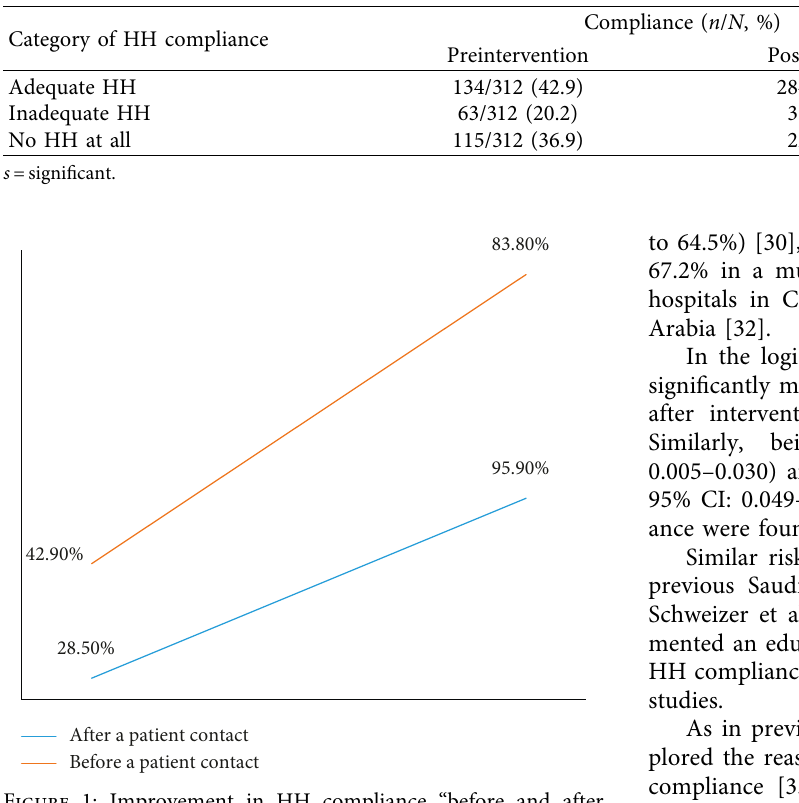
Figure 1: Improvement in HH compliance “before and after patient contact” following the